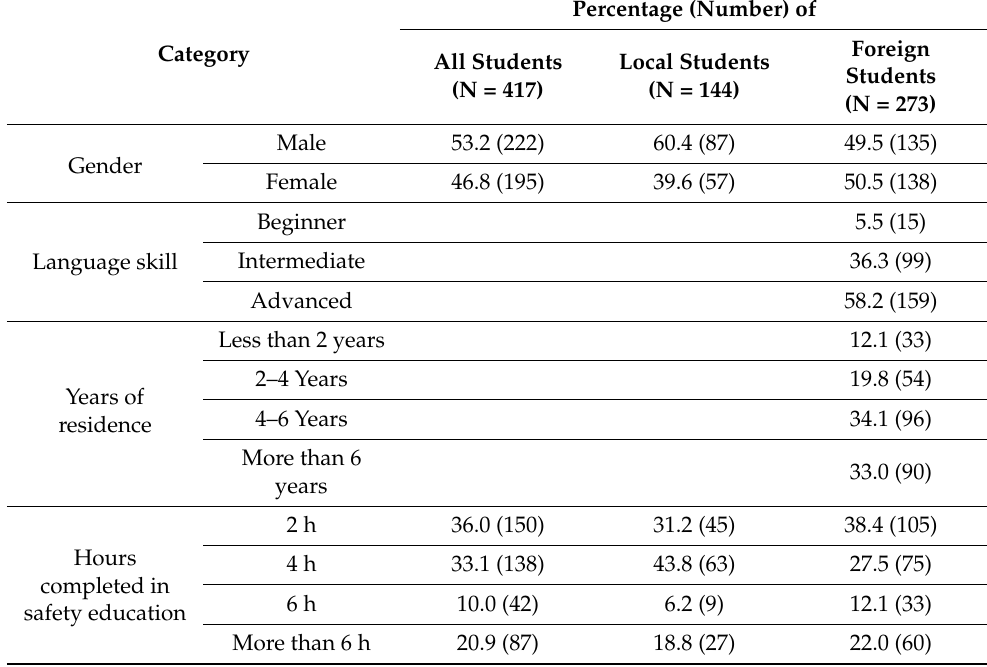
Table 2. Demographic information of survey